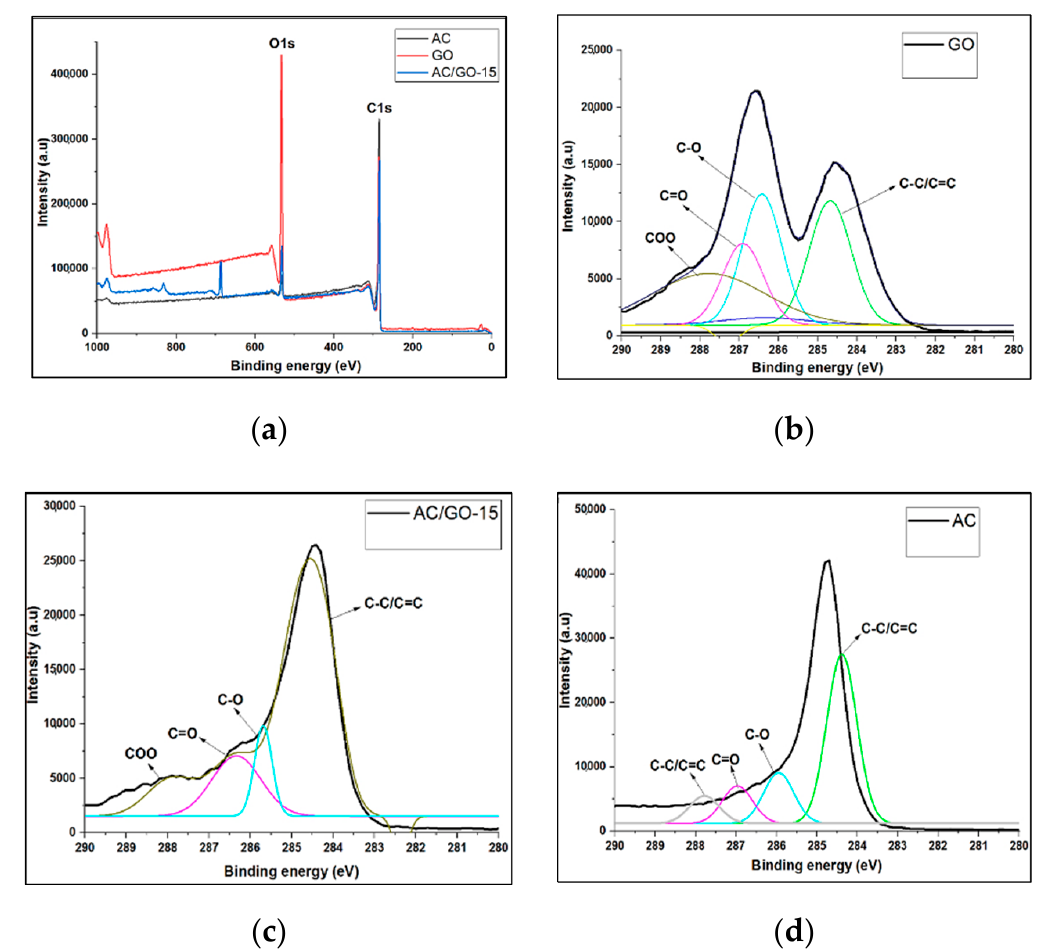
Figure 7. Whole XPS spectra of ( a ) AC, GO and AC / GO-x (where x is 15 wt.% GO). XPS spectra of C 1s peak of ( b ) AC ( c ) AC / GO-15 and ( d ) GO.